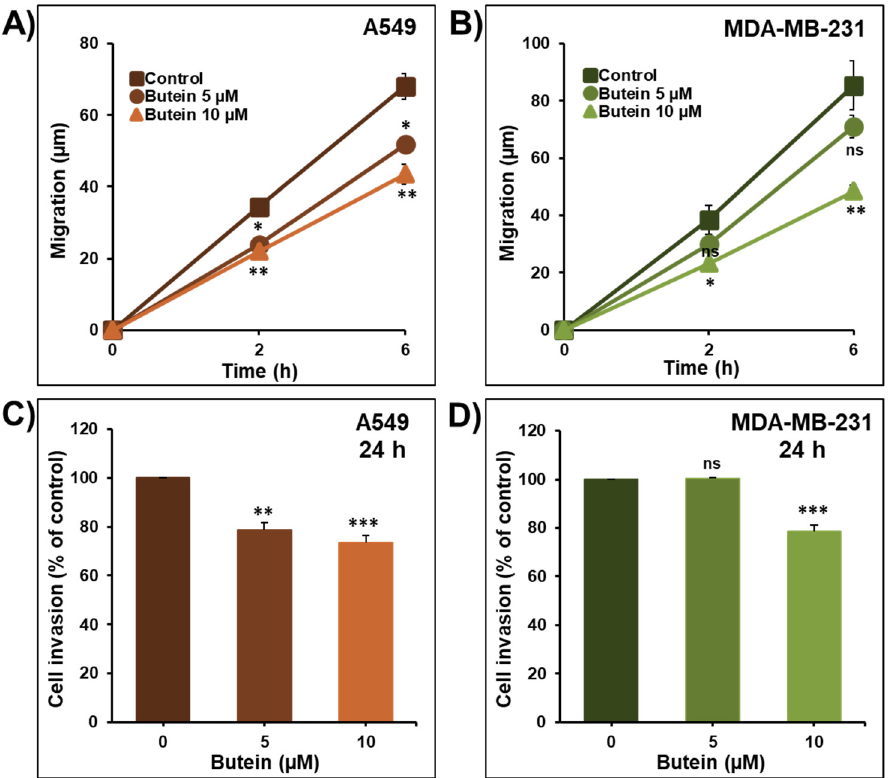
Figure 4. Butein impairs cancer cell migration and invasion. Wounds were introduced in A549 ( A ) and MDA-MB-231 ( B ) cells’ confluent monolayers cultured in the presence or absence (control) of butein (5 and 10 µM). The mean distance that cells travelled from the edge of the scraped area after 2 and 6 h was measured using an inverted microscope. A549 ( C ) and MDA-MB-231 ( D ) cells were incubated for 24 h in the presence or absence of butein (5 and 10 µM). Cells that invaded the Matrigel and crossed the 8 µm pores insert were determined using the CellTiter-Glo Luminescent Cell Viability Assay. All experiments were repeated at least three times. Columns or shapes represent means; bars represent S.E.M. * Significantly different at p < 0.05, ** Significantly different at p < 0.01, *** Significantly different at p < 0.001. ns—non-significant.